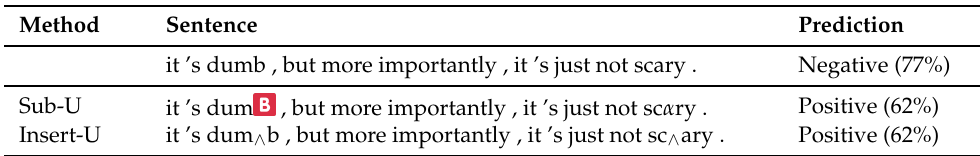
Table 5. Our perturbation methods. The target model is CNN trained with SST-2. ‘ ∧ ’ indicates the position of ‘ZERO WIDTH